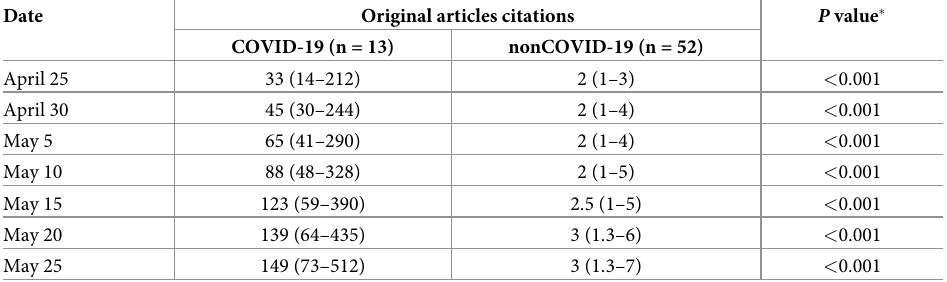
Table 3. Google Scholar citations of original articles published between March 12 and April 12,